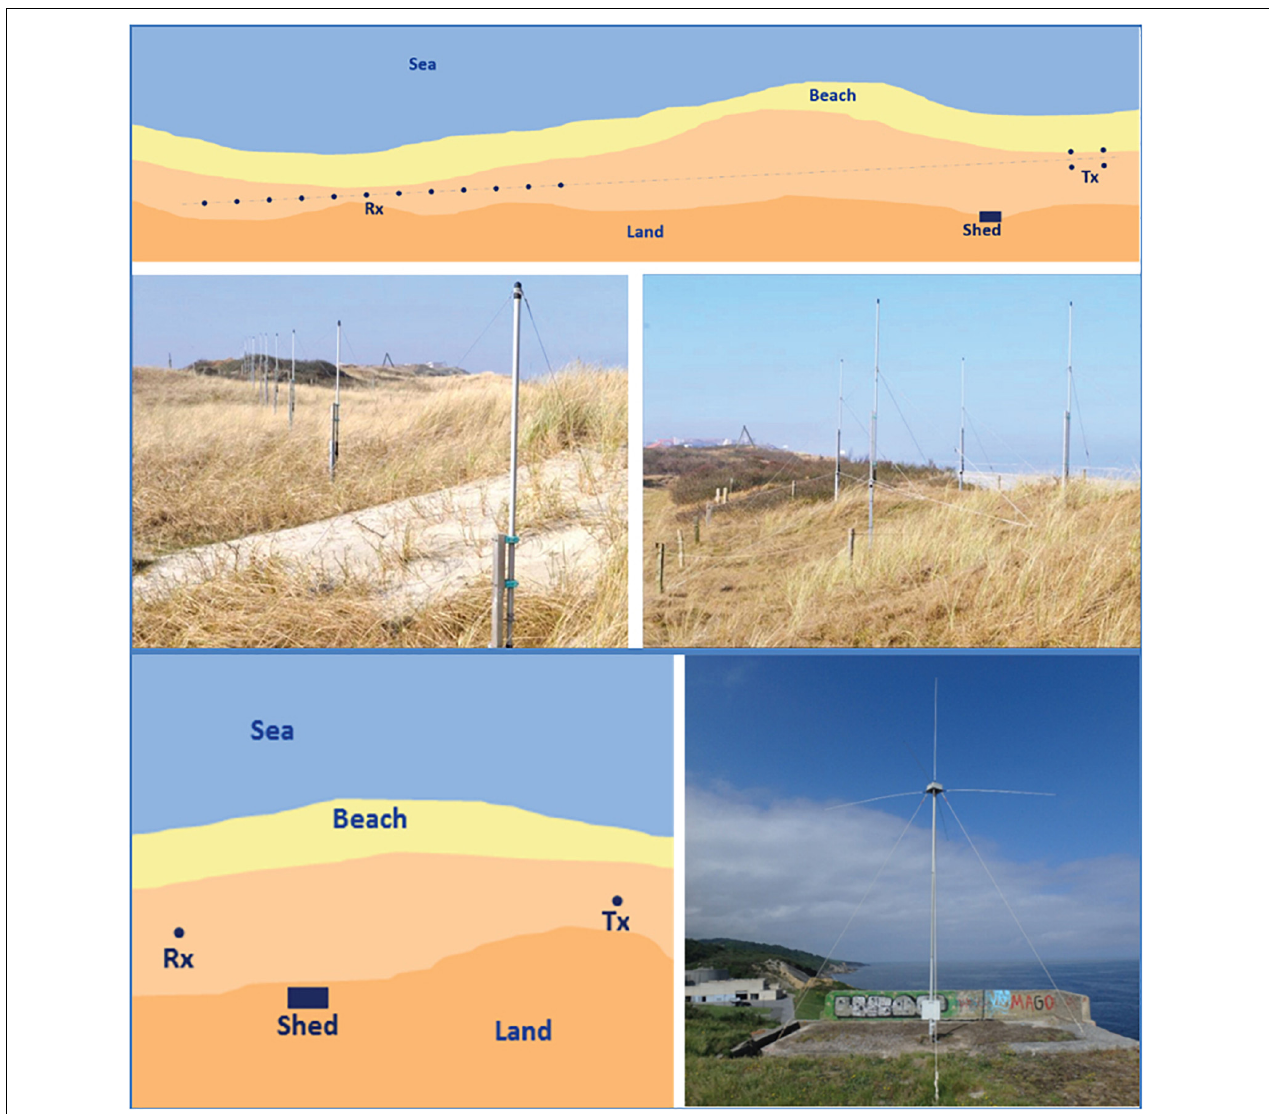
FIGURE 2 | Upper panel shows a typical setup of a beam forming system. The photos show the antennas placement of a WERA system on the island of Wangerooge at the German coast of the North Sea. The receive antenna array (Rx) is shown on the left-hand side and the transmit array (Tx) on the right hand side, respectively. The bottom panel shows a typical direction finding HF radar system setup for the low frequency (4, 5, and 9 MHz) bands (left hand side). To the right, the SeaSonde installed at Matxitxako Cape (northern coast of